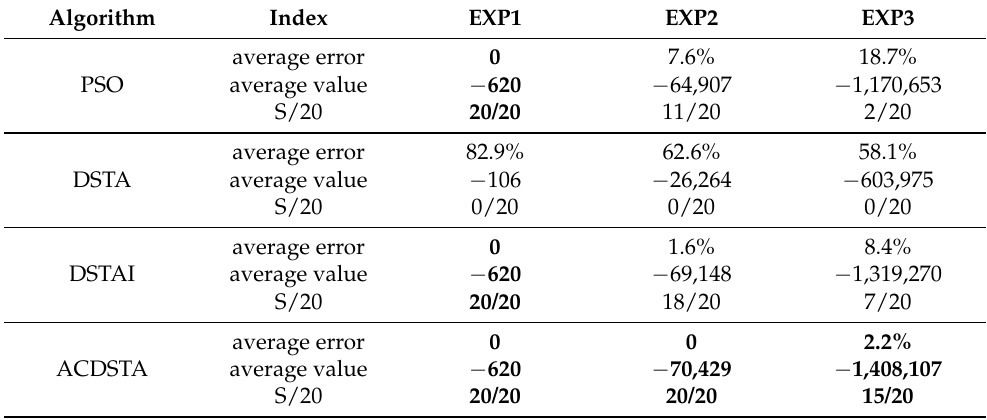
Table 1. Results of unconstrained integer